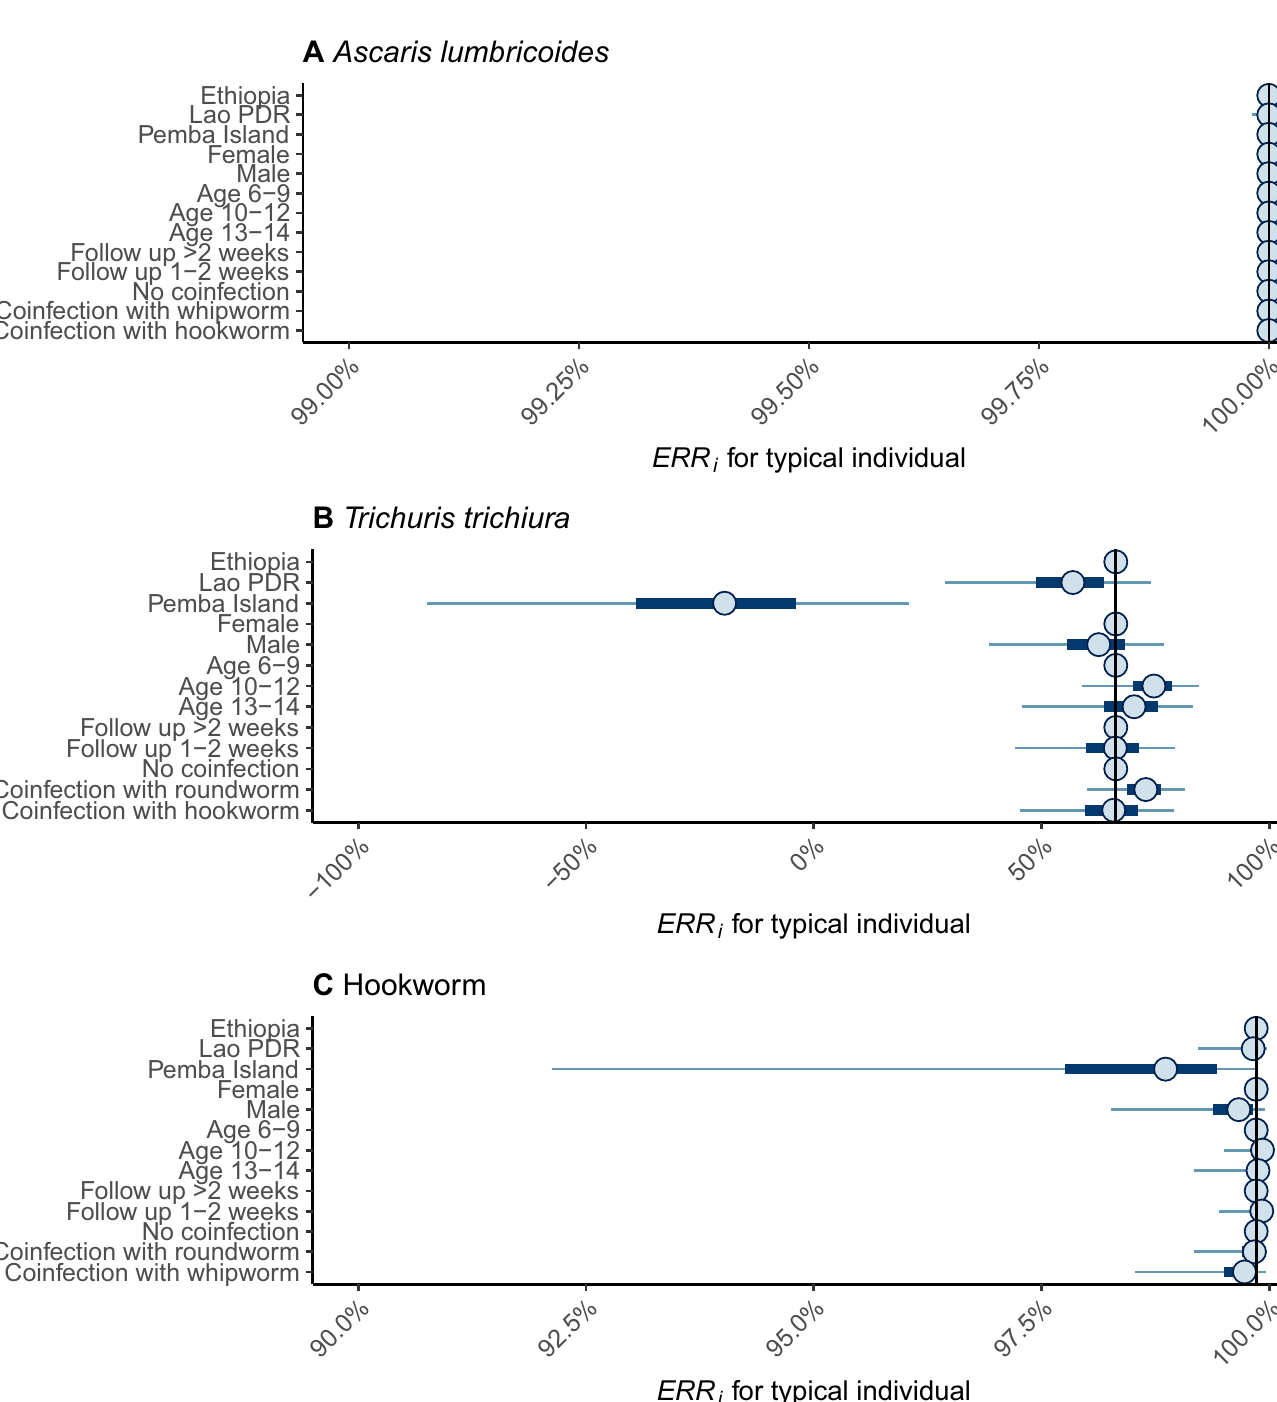
, were i (i.e., with fixed effects set to the reference i